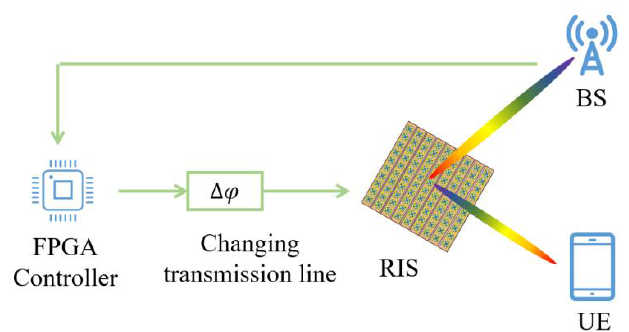
Figure 5. Shape-adaptive RIS with scalable unit sizes.